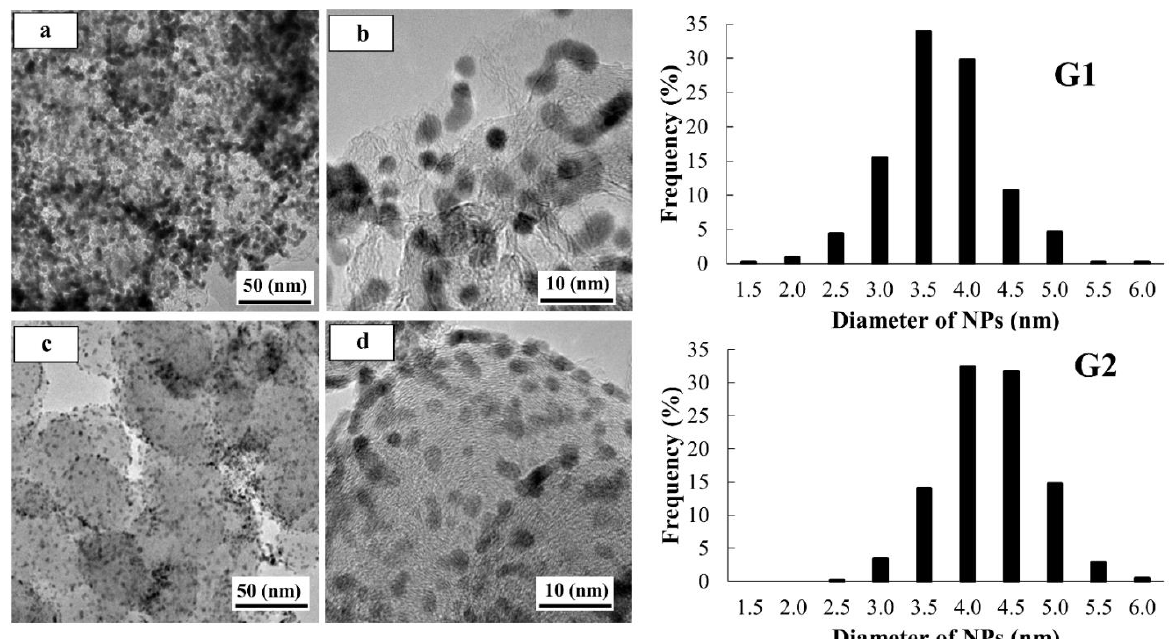
Figure 4. TEM micrographs of Pt/C catalysts: ( а , b ) G1 and ( c , d ) G2, and histograms of the NP size distribution in the corresponding materials.